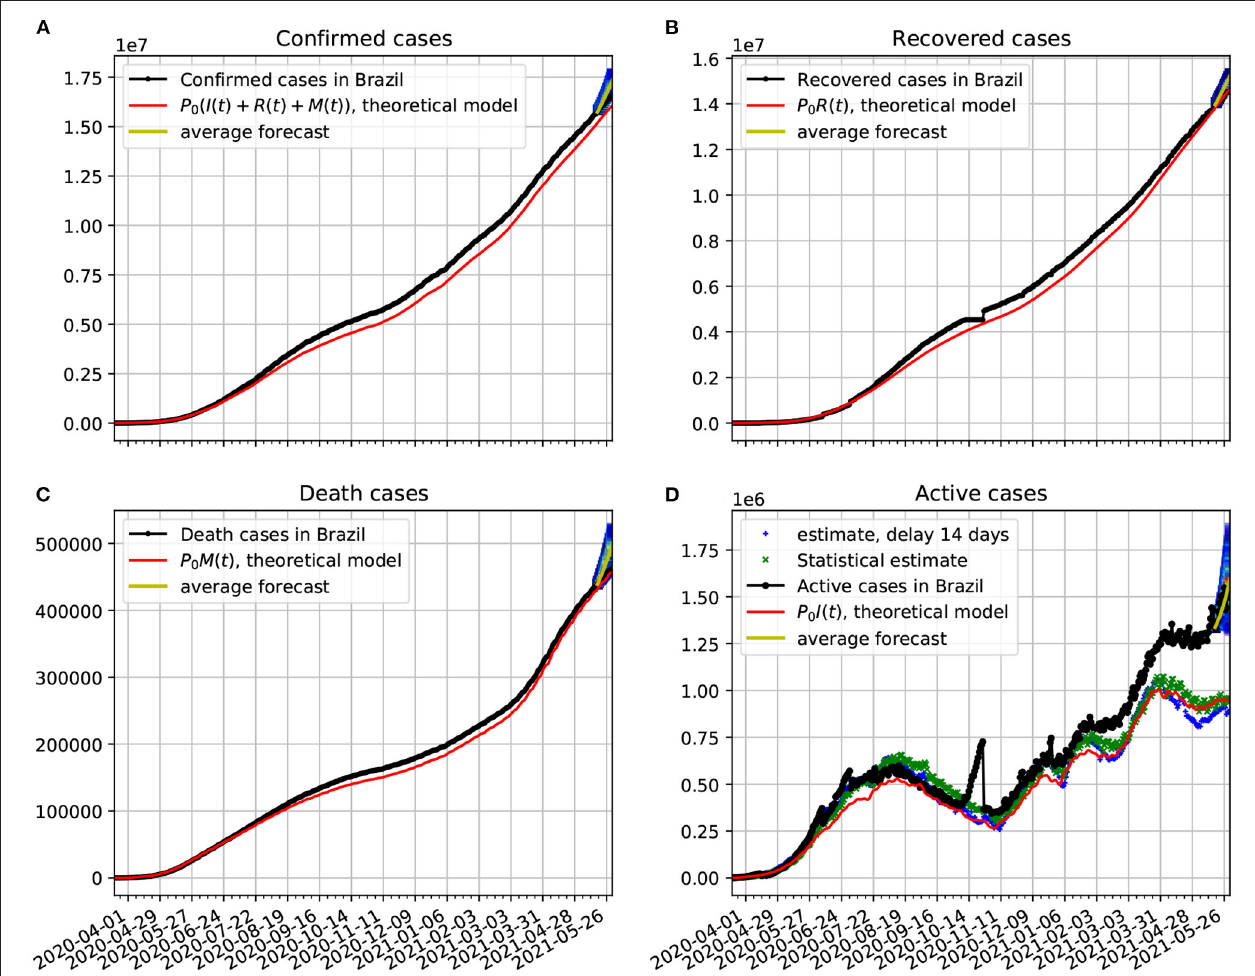
14 and the parameters estimated in Figure 5 . (A) =